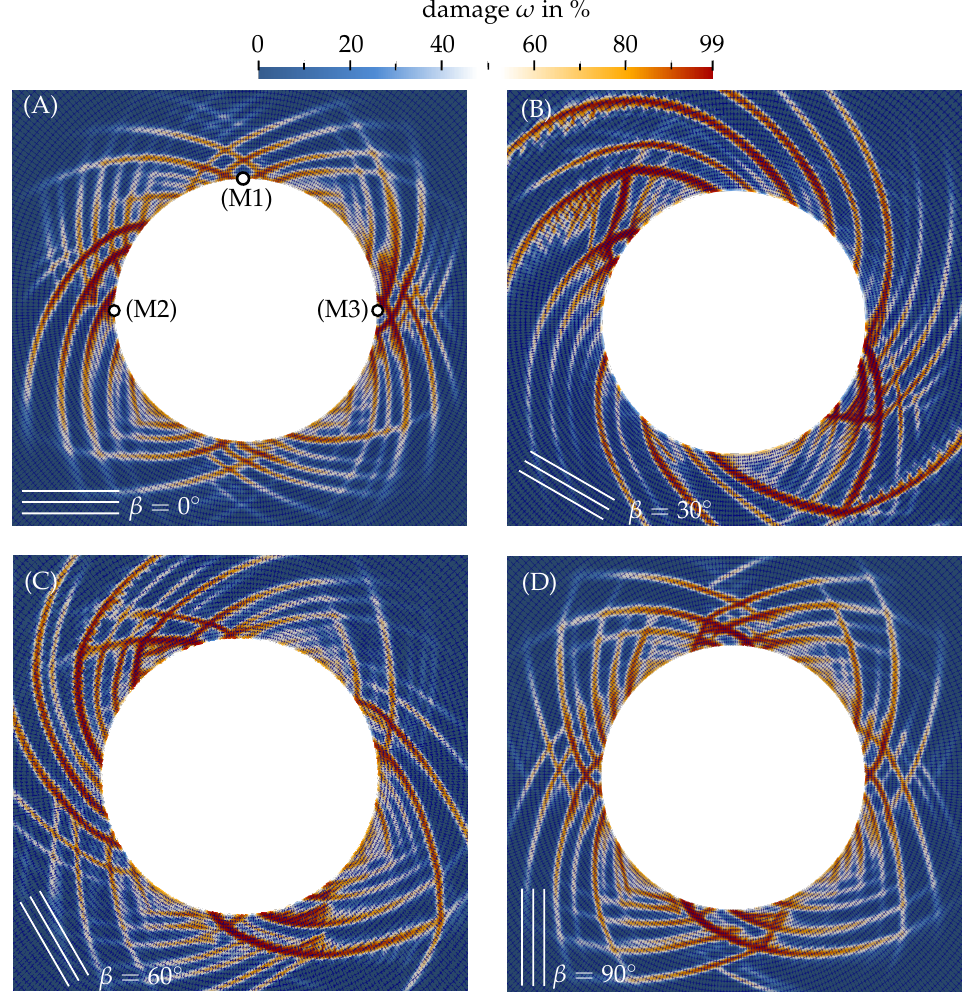
Figure 11. Distribution of the damage variable ω in the final stage of the simulation, determined by the transversely isotropic RDP model with the calibrated material parameters of section 3 for four different inclination angles β of the stratification planes, i.e., β = 0 ◦ (A), β = 30 ◦ (B), β = 60 ◦ (C) and β = 90 ◦ (D)